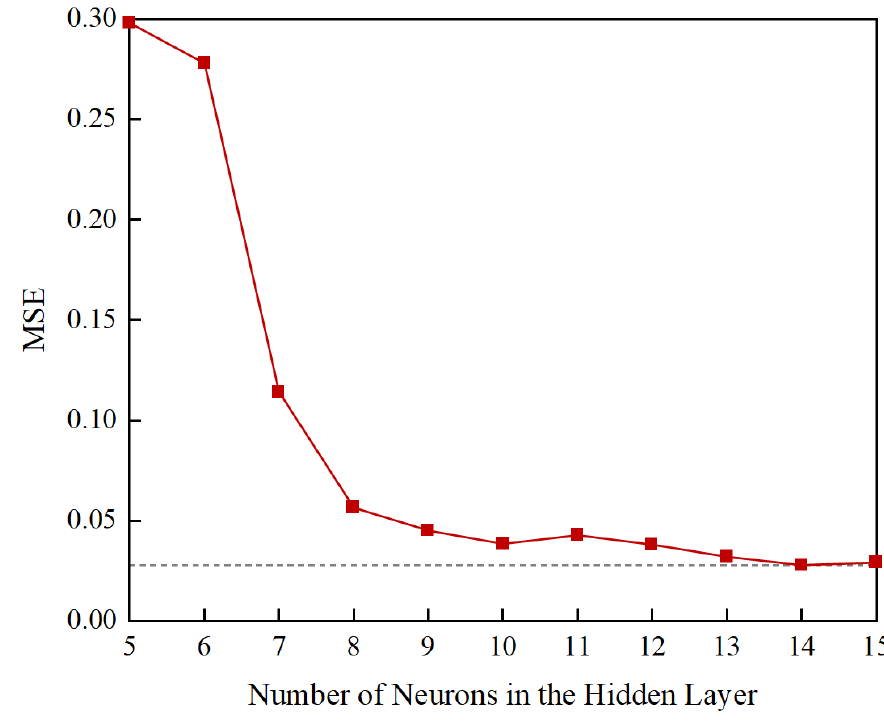
Figure 13. The effect of the number of hidden neurons on the prediction accuracy of the ANN-based model.